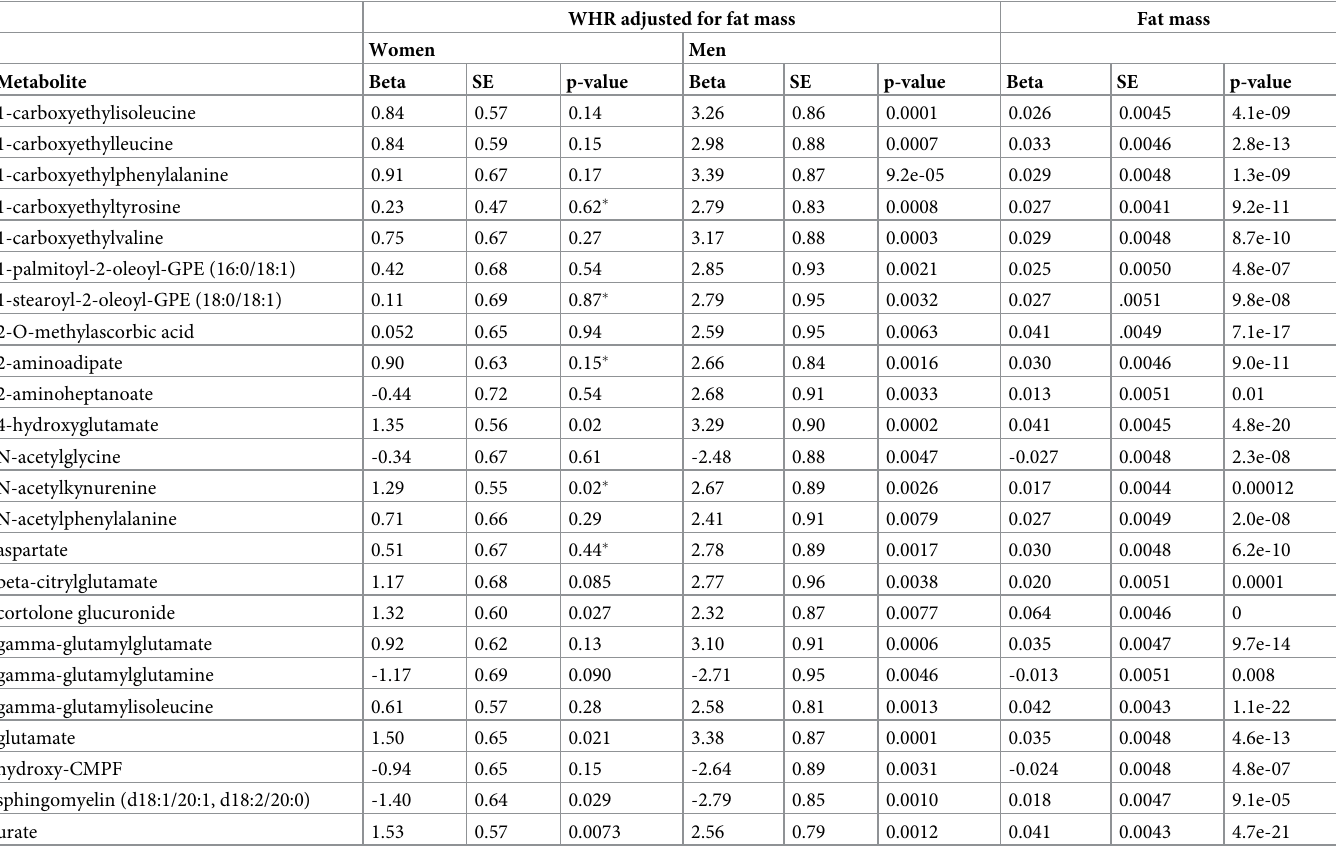
Table 3. Relationships between mass spectrometry-based metabolites and waist-hip ratio (WHR) in males and females and vs fat mass in both sexes combined. WHR adjusted for fat mass Fat mass